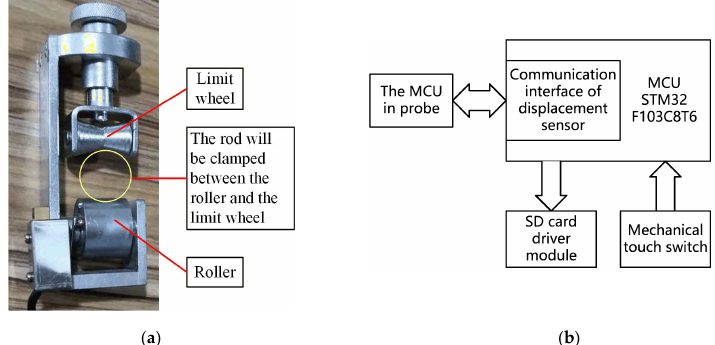
Figure 5. Displacement sensor: ( a ) physical drawing of displacement sensor; ( b ) block diagram of displacement sensor system.